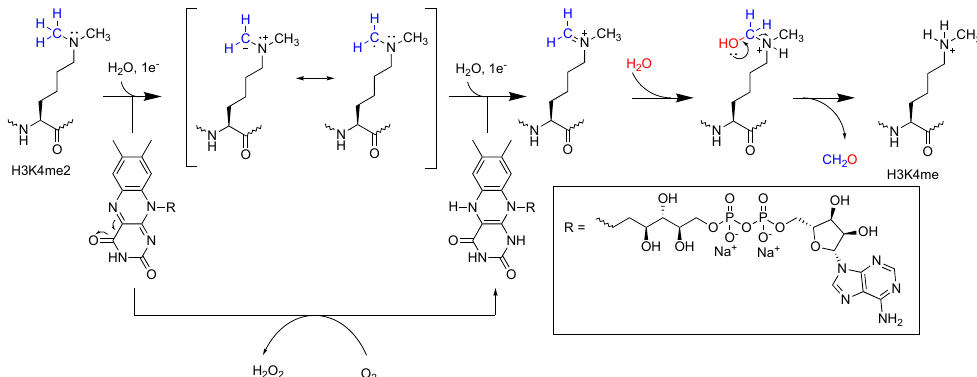
Figure 11. Mechanistic representation of flavin adenine dinucleotide (FAD)-dependent demethylation of dimethylated L-lysine residues by LSD1 and LSD2. LSD-catalyzed demethylation starts with flavin-mediated two-electron oxidation of methylated lysine, forming an imine intermediate upon reduction of the flavin cofactor. Subsequent hydration forms the N,O-hemiacetal, which results in collapse of the intermediate and formation of formaldehyde and demethylated substrate. FAD can be re-oxidized by molecular oxygen, releasing hydrogen peroxide from the catalytic cleft. This oxidation resets the active site back to its original state, ready to catalyze another demethylation [92].